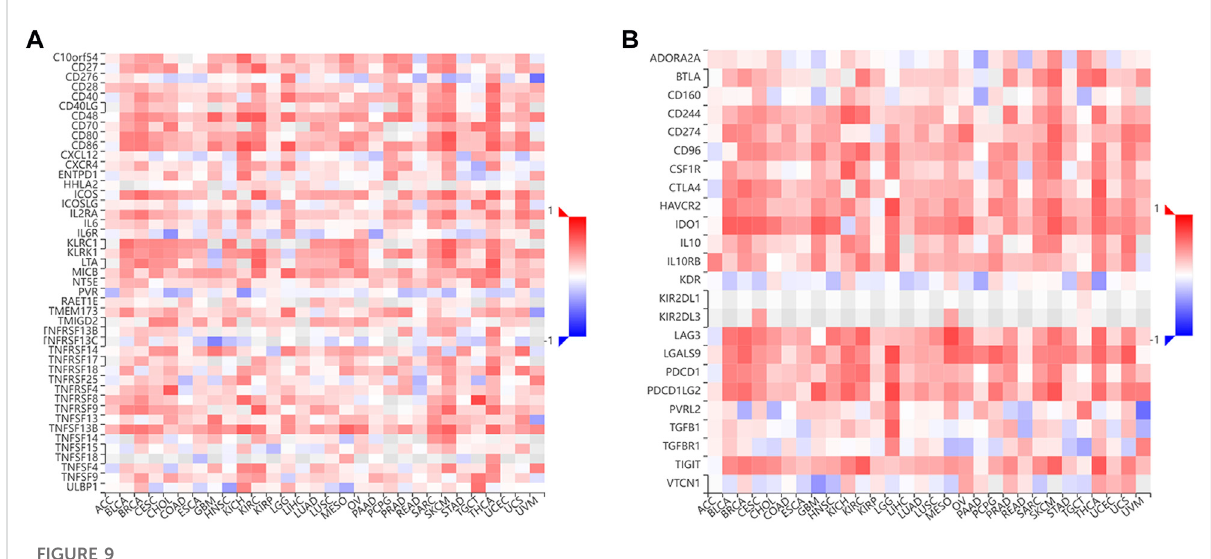
FIGURE 9 Correlation between NMI expression and immune checkpoint molecules. (A) The correlation heatmap between NMI expression and 45 immunostimulatory molecules was obtained from the TISIDB database. (B) The correlation Heatmap between NMI expression and 24 immunosuppressive molecules was obtained from the TISIDB